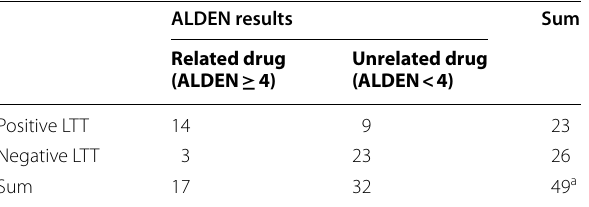
Table 1 Contingency table. Drug causality results in EN patients